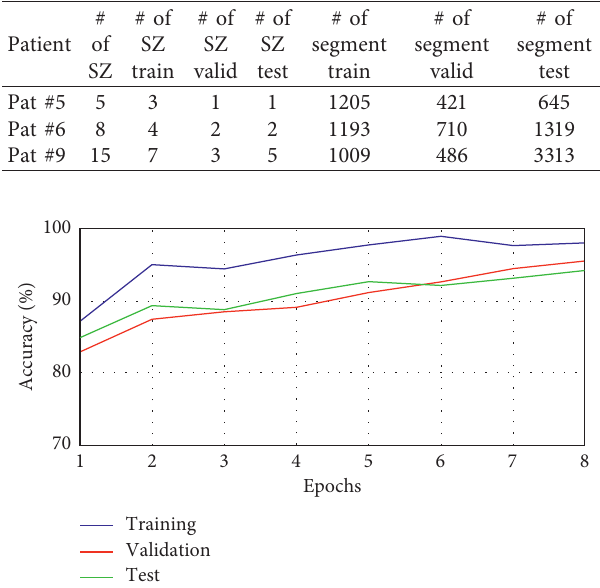
Table 2: Dataset composition for training, validation, and test.